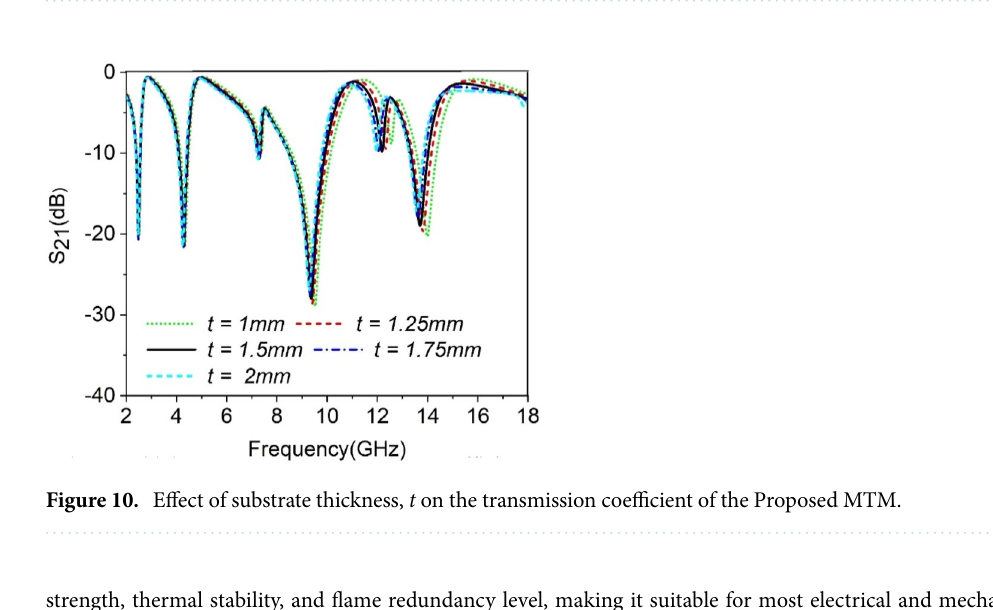
Figure 9. Study the effect of different substrate materials on S 21 .